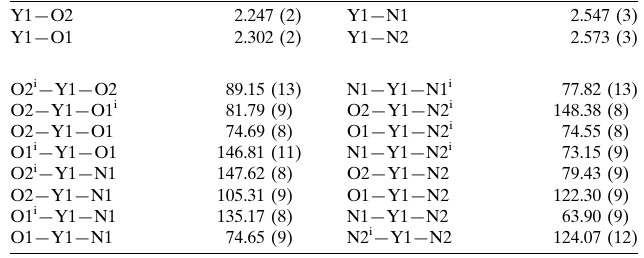
Selected geometric parameters (A˚ , (cid:2) ).